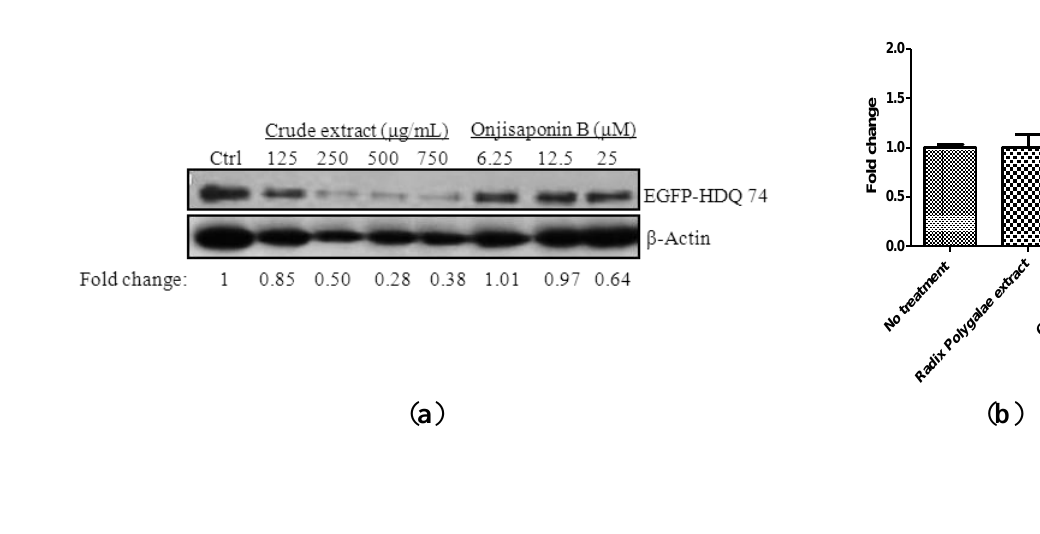
Figure 6. Radix Polygalae ethanol extract and onjisaponin B accelerate the clearance of mutant huntingtin and A53T α-synuclein, and inhibits α-synuclein oligomerization. ( a ) PC-12 cells transfected with huntingtin with 74 CAG repeats were treated with 24 h of Radix Polygalae extract or onjisaponin B at the indicated concentrations. Cell lysate was harvested and analyzed for EGFP and β-actin respectively; ( b ) PC-12 cells transfected with EGFP-HDQ 74 were analyzed by real time PCR on huntingtin level after 16 h of Radix Polygalae extract (500 μg/mL) or onjisaponin B (50 μM) treatment; ( c ) PC-12 cells transfected with EGFP-HDQ 74 were incubated with onjisaponin B (25 and 50 μM) for 24 h before fluorescent microscopy analysis; ( d ) Wild type Atg 7 and Atg 7-deficient MEF cells transiently transfected with EGFP-HDQ 74 were treated with 0–50 μM of onjisaponin B for 24 h before fluorescent microscopy analysis. Bar chart represents the percentage of cells with EGFP-HDQ 74 inclusion formation. Magnification, ×40. Bottom : Wild type Atg 7 and Atg 7-deficient MEF cells with EGFP-HDQ 74 overexpression were treated with 0–50 μM of onjisaponin B for 24 h before western blot analysis. Cell lysate was harvested and analyzed for EGFP, LC3 and β-actin respectively; ( e ) Doxycycline-inducible PC-12 cell lines transfected with mutant A53T α-synuclein were first induced with doxycycline (1 μg/mL) for 24 h and the expression of transgene was then switched off by the removal of doxycycline. Cells were then treated with Radix Polygalae extract ( left ) or onjisaponin B ( middle ) at the indicated concentrations for a further 24 h after doxycycline removal. Ctrl: cells without the addition of doxycycline; Dox: cells with the removal of doxycycline (1 μg/mL) after 24 h of induction but without Radix Polygalae extract or onjisaponin B treatment. Right : doxycycline-inducible PC-12 cell lines transfected with mutant A53T α-synuclein were incubated with onjisaponin B (25 μM) at the indicated time points. Band intensities of the blot were quantified using densitometric analysis and normalized to β-actin. Data is expressed as a fold change over control; ( f ) HeLa cells transfected with both GNS and SGC plasmids were incubated with Radix Polygalae extract or onjisaponin B at the indicated concentrations. Right : bar chart indicated the percentage of cells with green fluorescent protein (GFP)-positive signal under these treatments. Data from the flow cytometry analysis is represented as means ± S.D. of three independent experiments. *** p < 0.001; ** p < 0.01; * p < 0.05. Scale bar: 15